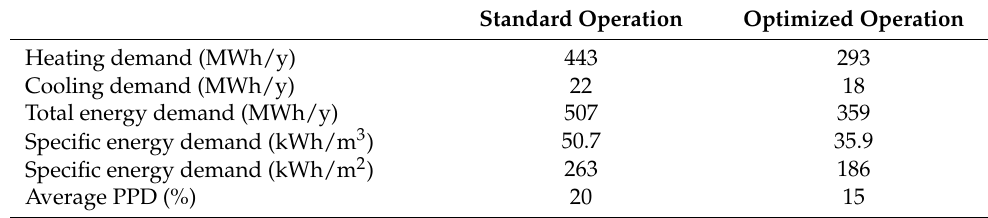
Table 4. Comparison between standard operation and optimized